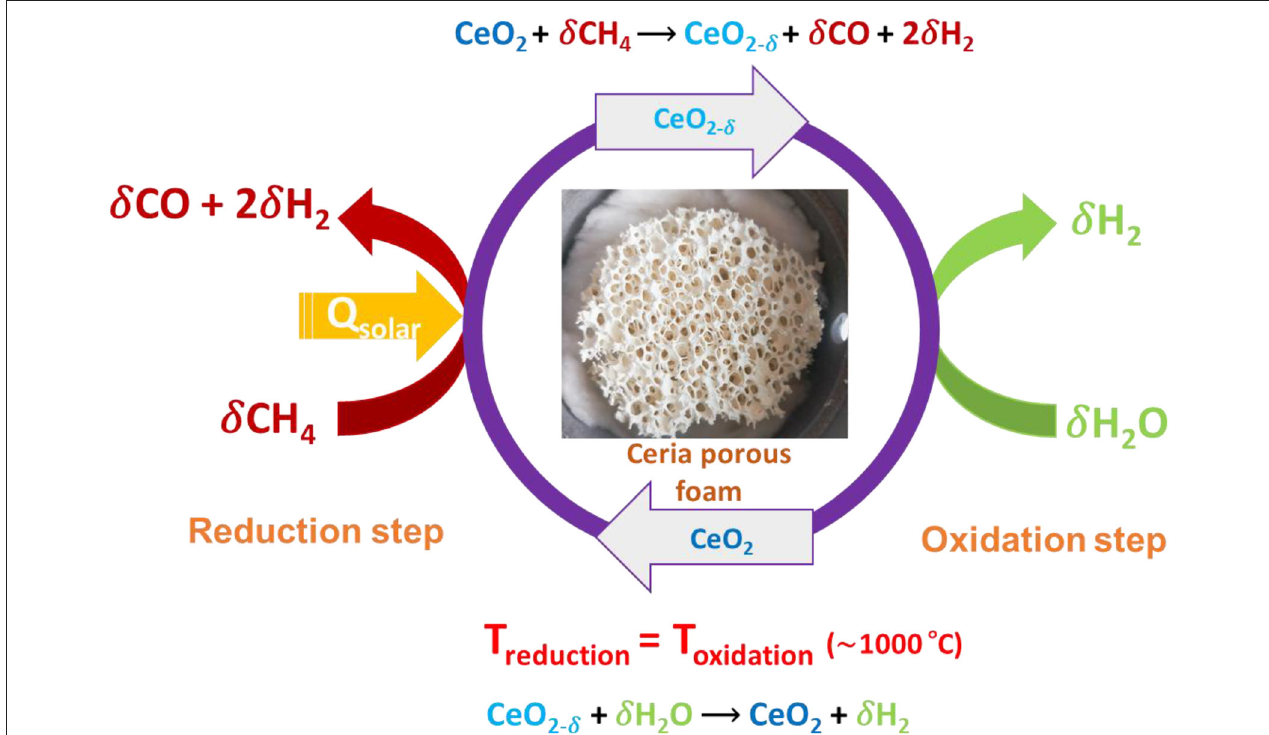
FIGURE 1 | Ceria two-step redox cycle with ceria reduction coupled to the partial oxidation of methane (reduction step) and H 2 O splitting during the oxidation reaction (oxidation step).